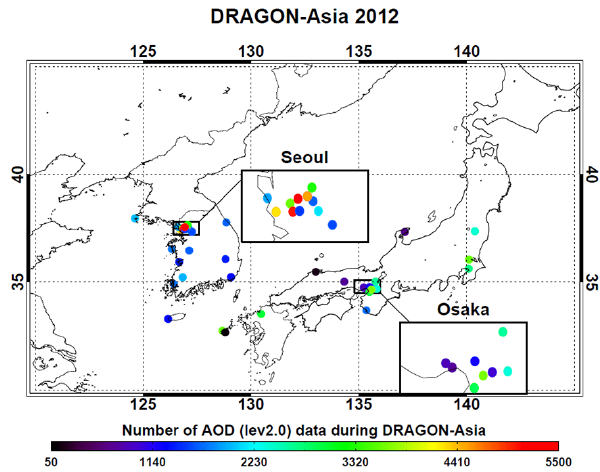
Figure 1. Location and number of data points of the AERONET sun photometers deployed during DRAGON-NE Asia 2012. The color of each symbol represents the number of AOD (level 2.0) data points measured for the